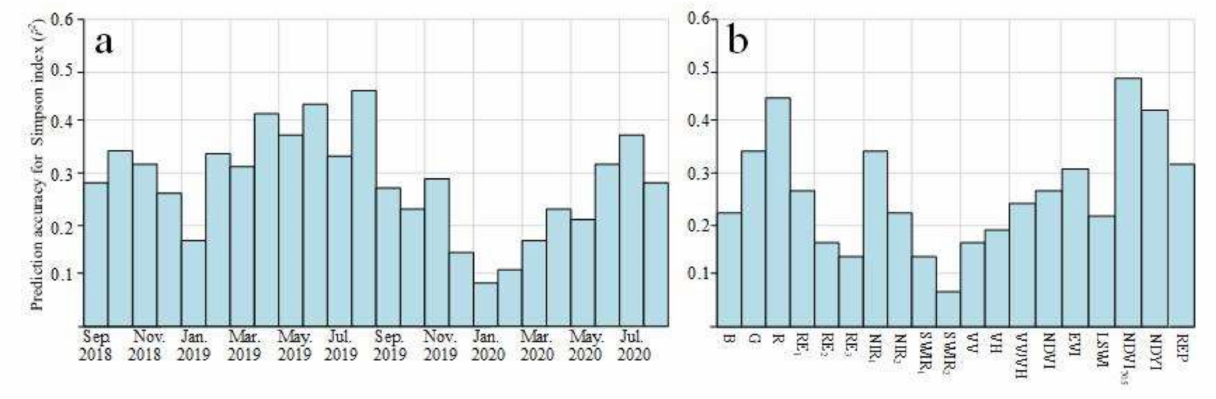
Figure 9. Importance of ( a ) 24 single-date (from September 2018 to August 2020) Sentinel-1 and -2 satellite imagery and ( b ) 19 single-feature (including 13 band features and 6 vegetation indices) imagery using random forest methods to predict the effects of the Simpson index on prediction accuracy. Table 1 presents the definitions of the acronyms for band features and vegetation indices.